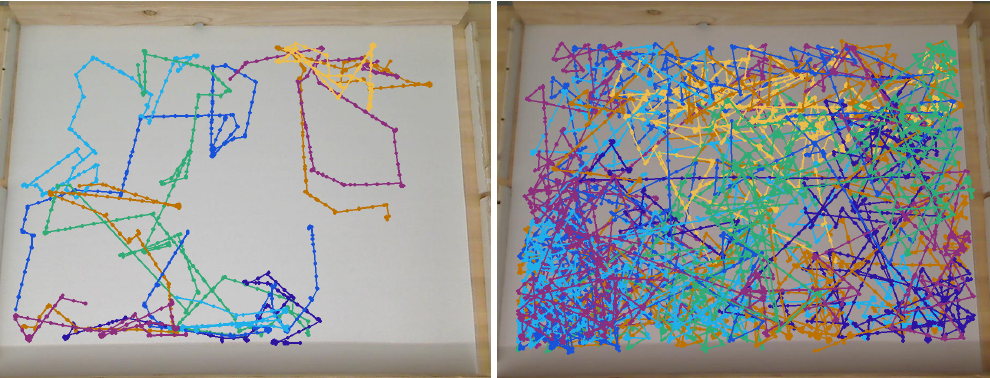
Figure 21. Summary of experimental runs on white poster for all 12 initial positions with ( left ) basic chemotaxis controller and ( right ) RapidCell controller. Each run is shown in a different